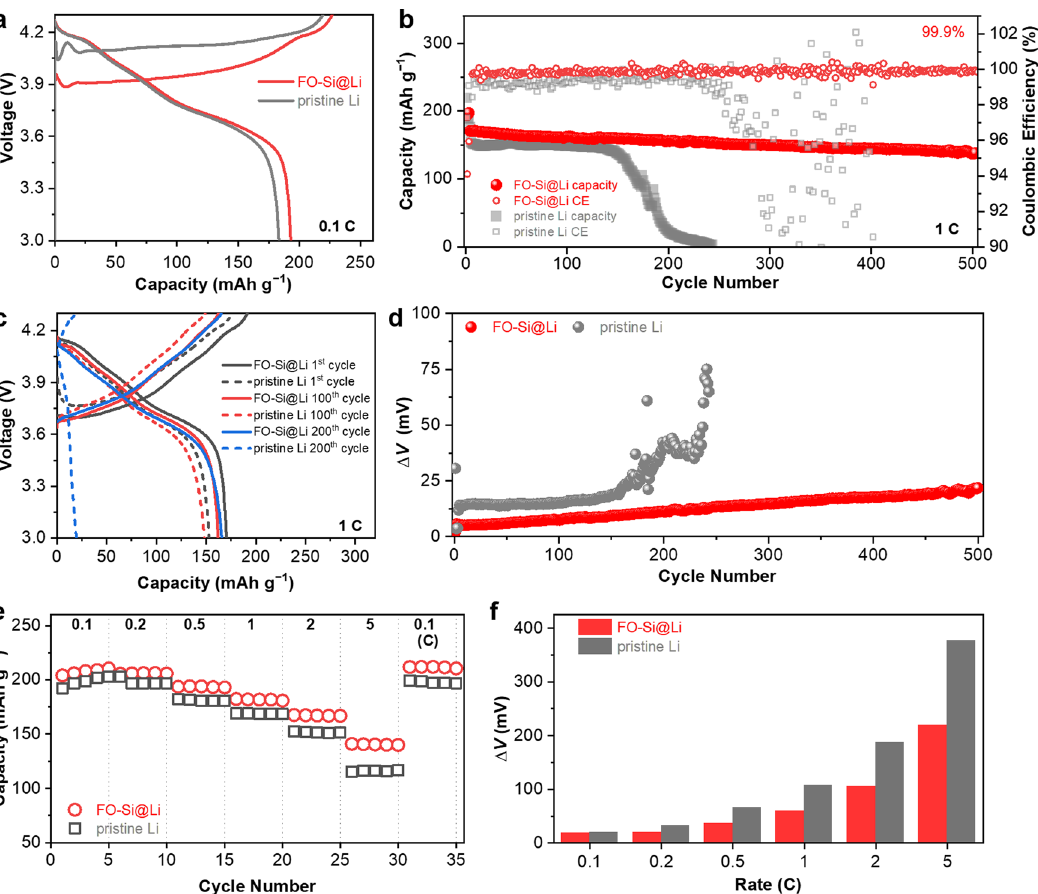
Fig. 5 Electrochemical performance of Li||NCM811 coin cells with a thick Li of 500 μ m. a The initial GCD curves at 0.1 C. b Cyclic performance at 1 C after three formation cycles at 0.1 C. c Selected GCD curves at 1 C. d Overpotential ( Δ V ) at different cycles. e Rate capability and f its corresponding overpotential ( Δ V ) at various